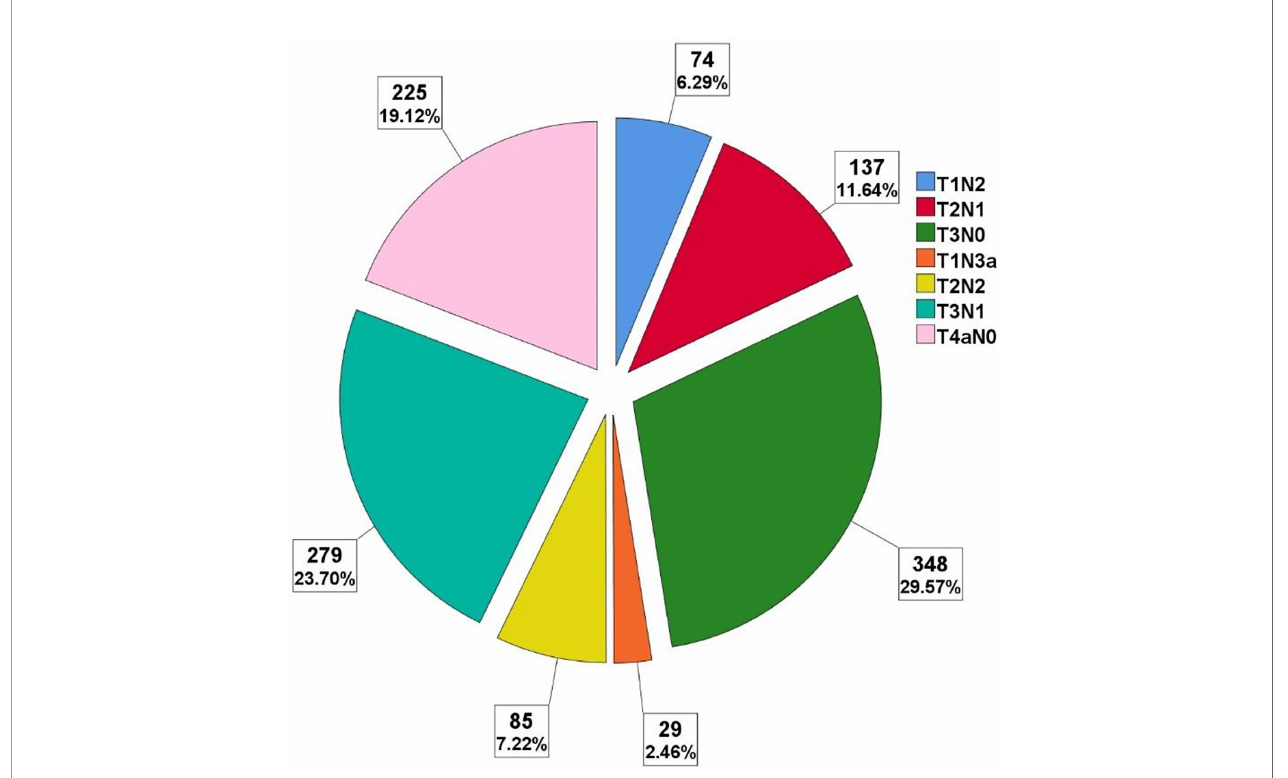
FIGURE 1 | Cases and proportion of different pTN stages.